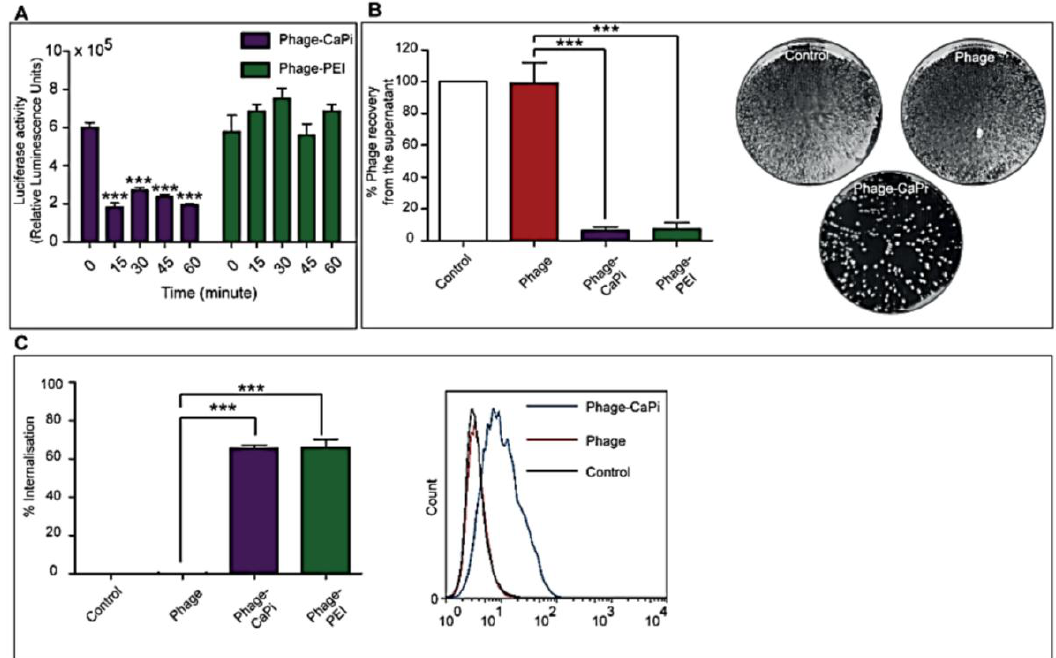
Figure 4. Investigation of cell transduction mechanisms mediated by phage-CaPi and phage-PEI complexes. HEK293 cells were treated with phage premixed with optimized concentrations of CaPi and PEI. ( A ) Effect of complex formation time before addition to cells. Phage-CaPi or phage-PEI was incubated for various times before being applied to cells. Experiments were performed in triplicate; ( B ) Depletion assay analysis of free cell-unbound phage particles from the supernatant of transduced cells. Photographs representing colony count of E. coli cells from the depletion assay; ( C ) Evaluation of internalization efficiency of hybrid phage complexes. Flow cytometric analysis of uptake of phage-CaPi and phage-PEI complexes or control phage alone. Asterisks are defined as: *** p < 0.001.